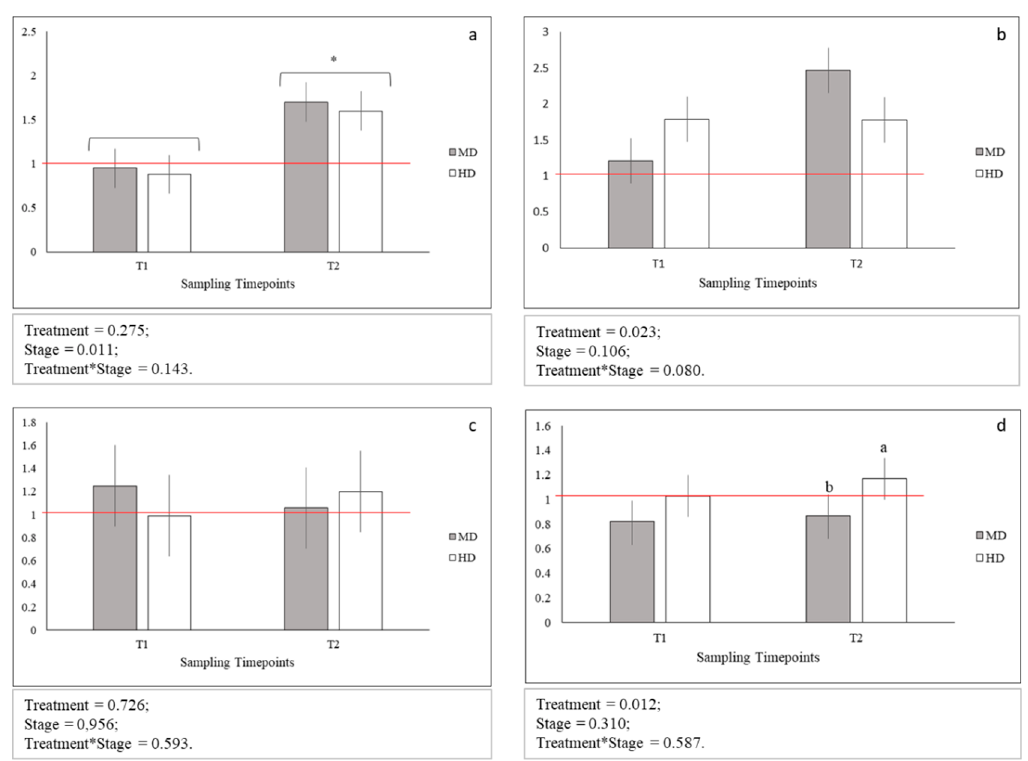
Figure 3 . Relative gene expression of: ( a ) glut1 ; ( b ) glut2 ; ( c ) glut4, and ( d ) hsp70 ; Means with asterisks